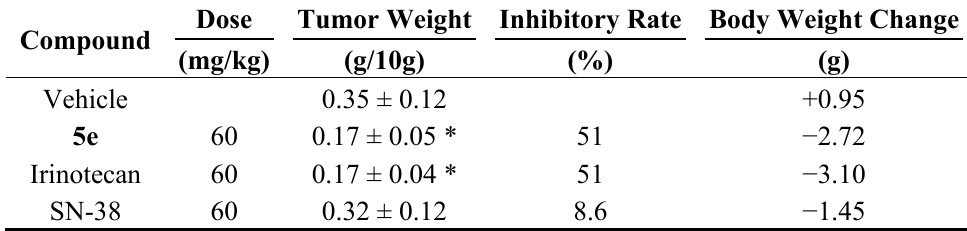
Table 5. Tumor growth inhibitory activity of 5e in a human colon xenograft model in vivo (x ± SD). Dose Tumor Weight Inhibitory Compound